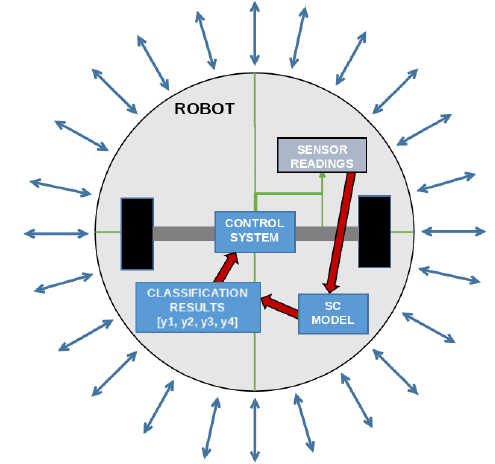
Figure 8. The flowchart of the model application on a theoretical mobile robot that uses the developed